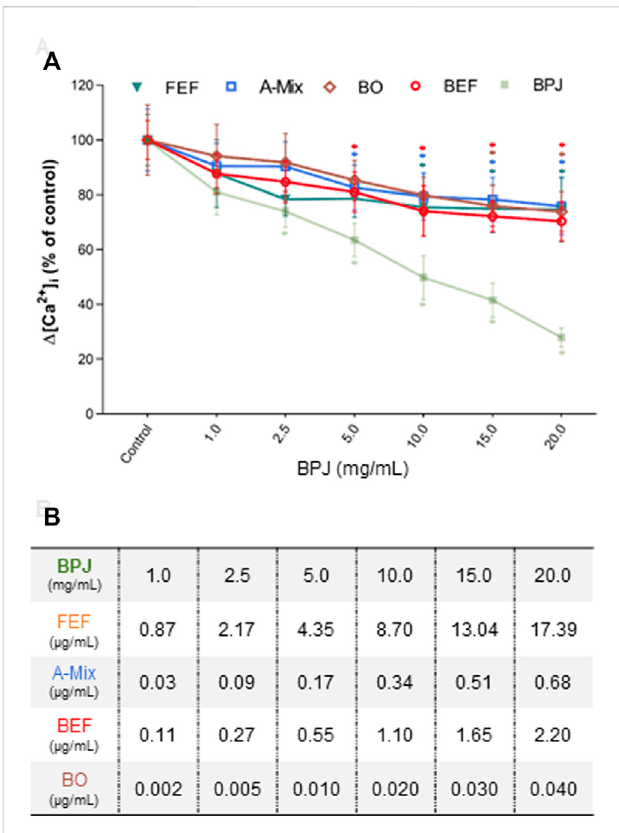
FIGURE 1 Concentration-dependent effects of BPJ fractions/compounds on the OT-induced increase of [Ca 2+ ] i. Myometrial hTERT-C3 cells were pre-treated with BPJ, FEF, A-Mix, BEF or BO prior to stimulation with 100 nM of OT (A) . Values represent the mean ± SEM of six independentexperimentsperformedinquadruplicateandareexpressed as percentage of control; * p < 0.05. In (B) , the concentrations of FEF, BEF, A-Mixand BO correspondingto theBPJ concentrationsare